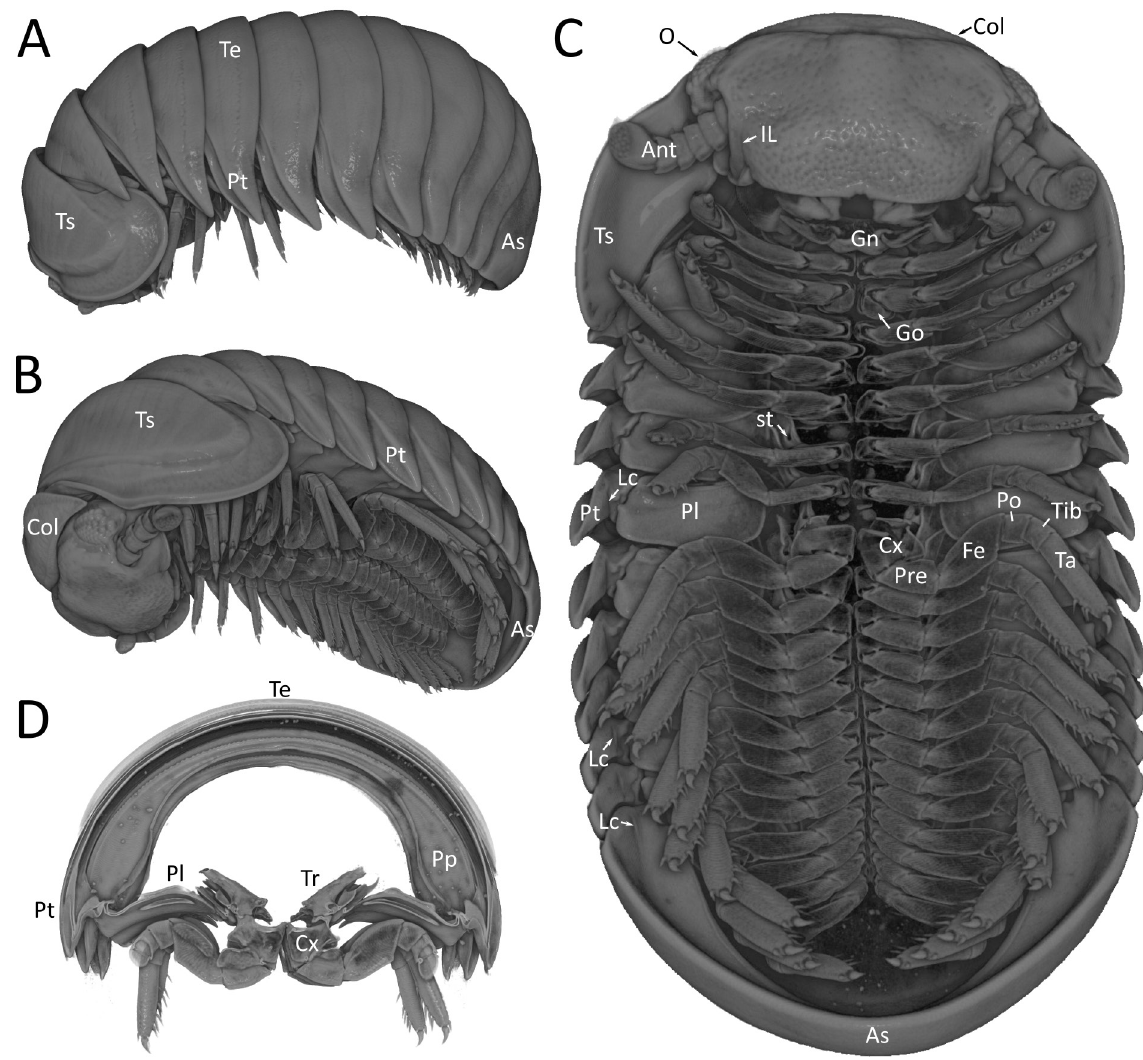
Fig. 12. Zephronia viridisoma Rosenmejer & Wesener sp. nov., paratype, ♀